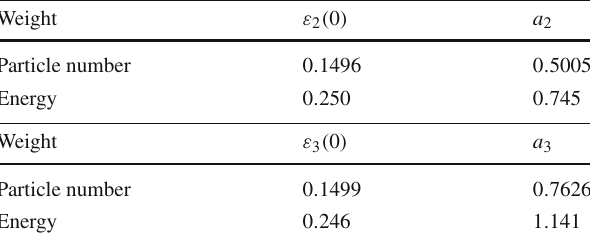
Table 1 Parameters of the fit function Eq. (18) for ε n with particle- number and energy weight